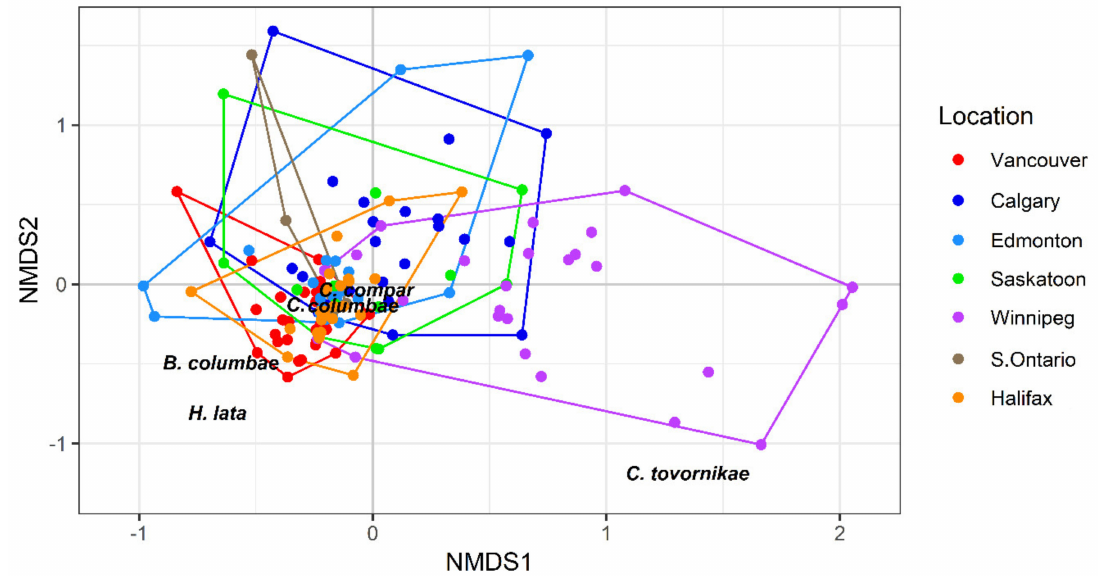
Figure 7. Non-metric multidimensional scaling plot of louse assemblages (log [x + 1] abundance data) infesting Columba livia (n = 162) sampled from seven locations across Canada. Locations of louse names indicate the direction of their vectors. Stress = 0.1189. Locations that have significantly different louse assemblages are Vancouver and Calgary, Vancouver and Winnipeg, Edmonton and Winnipeg, and Winnipeg and